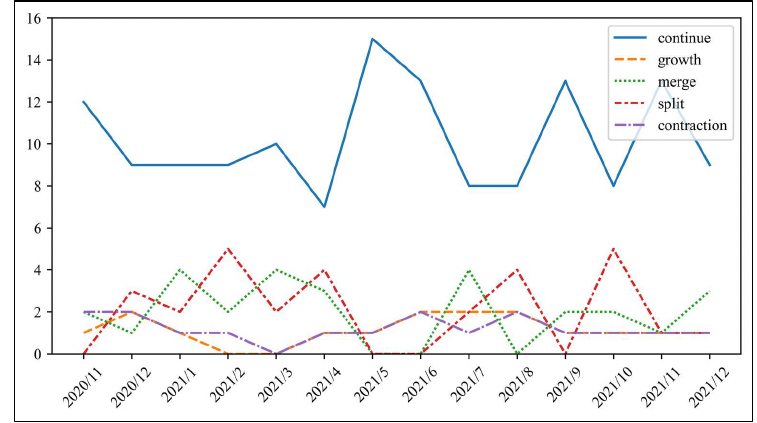
Figure 6. The numbers of five dynamic events in each period.